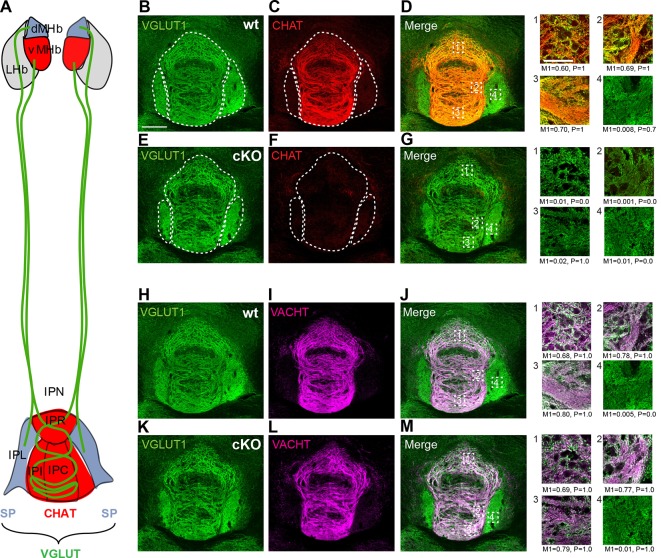
Distribution of cholinergic and glutamatergic axonal terminals in IPN subnuclei.(A) Schematic representation of the segregated projections of medial habenular neurons to IPN subnuclei. The dorsal part of the MHb (dMHb, blue) consists of peptidergic neurons (positive for substance P, SP) that project to the lateral part of the IPN (IPL, blue). The ventral part of the MHb (vMHb, red) contains cholinergic neurons (positive for CHAT, red) that project to the rostral (IPR), intermediate (IPI) and central (IPC) subnuclei of the IPN (red). Both types of projections co-release glutamate (VGLUT, green). (B–M) Double immunostaining and Manders’ colocalization coefficient analyses of glutamatergic and cholinergic markers in different subnuclei of the IPN. M1: index of colocalization and P: significance of correlation were measured in the indicated dotted squares which are located: 1 in IPR, 2 in IPI, 3 in IPC and 4 in IPL. (B–G) In wt mice, VGLUT1 (green) and CHAT (red) show the strongest index of colocalization in the IPC and no colocalization in the IPL. CHAT immunoreactivity signal is absent in the IPN of ChAT-cKO mice. (H–M) Analyses of VGLUT1 (green) and VACHT (violet) show the highest colocalization index also in the IPC of both wt and ChAT-cKO, and no colocalization in the IPL. The M1 and the P values shown below panels 1–4 were calculated from one image for each IPN subnucleus. cKO: Conditional knockout; IPN: Interpeduncular nucleus; MHb: Medial habenula; wt: Wild type.